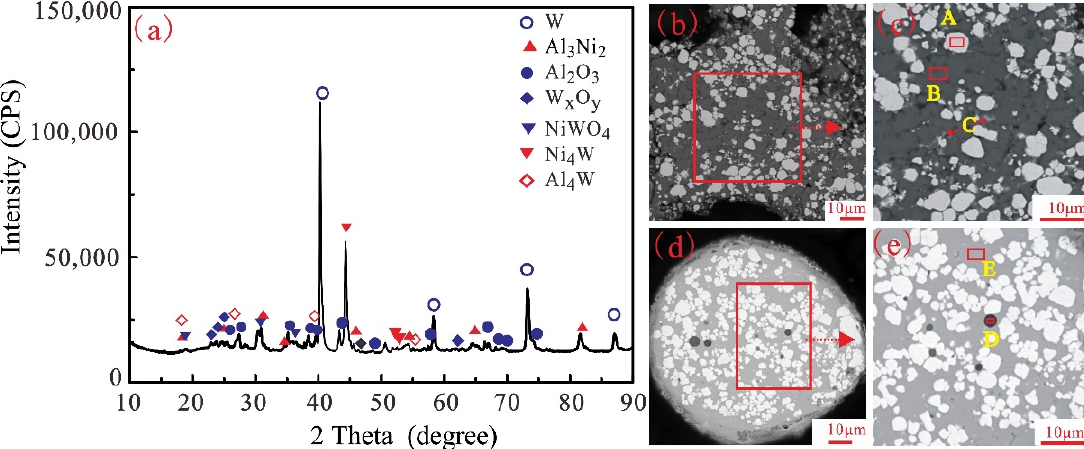
Figure 7. XRD patterns and SEM images of recovered (48Al–52Ni) 100 ‐ x W x fragments. ( a ) XRD patterns; ( b ) irregular fragments; ( c ) magnified image for ( b ); ( d ) spherical particle; ( e ) magnified image for ( d ).